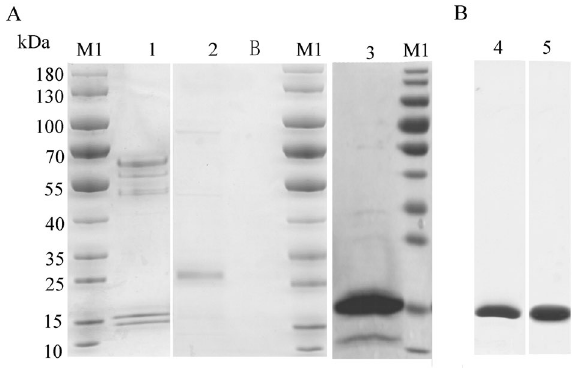
Figure 1. The SDS–PAGE gel of the VHH-B11. M1: the protein marker (Fermentas, USA). ( A ) Lane 1: the VHH-B11 antibody expressed by BL21 E. coli ( pET28a ); lane 2: the VHH-B11 expressed by TG1 E. coli ( pMECS ); lane B: blank control; lane 3: the VHH-B11 expressed by HB2151 E. coli ( pMECS ); ( B ) lane 4: the VHH-B11 expressed by P. pastoris X33 ( pPICZα ); lane 5: the VHH-B11 expressed by HEK293F ( pCDNA3.4 ).